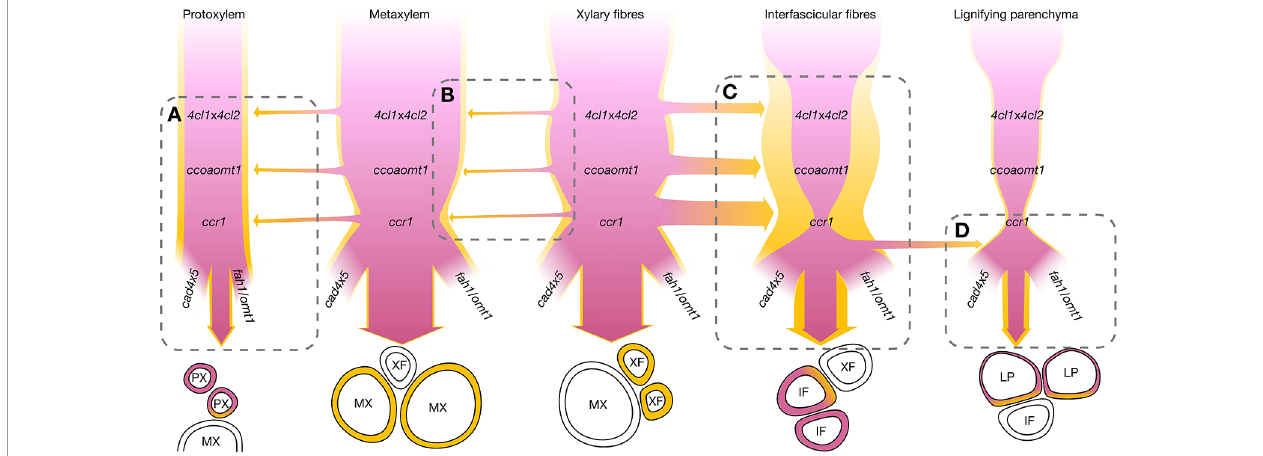
FIGURE 9 | Schematic representation of the regulation of coniferaldehyde accumulation in lignin for different cell types focusing on the genetic controls of the metabolism and cooperative supply. The sequence of the mutants in the metabolic pathways leading to coniferaldehyde are shown for each cell type. The cell autonomous control of coniferaldehyde accumulation is indicated by the width of the pink ribbon modi fi ed accordingly to the effect of the different mutations. The cell cooperative control of coniferaldehyde accumulation are indicated by the width of yellow ribbon with speci fi c neighboring cell types modi fi ed accordingly to the effect of the different mutations. Only interactions between neighboring cells are presented. (A) PX incorporate more coniferaldehyde when adjacent to MX independently of any particular mutations. (B) MX incorporates coniferaldehyde supplied by adjacent XF. The magnitude of cooperativity is largely independent of mutations, but both cell types are slightly reduced in coniferaldehyde in ccr1. Deciphering the relative impact of XF on MX is complicated by their constant close adjacency. (C) IF coniferaldehyde accumulation is highly affected by the 4cl x 4cl2, ccoaomt1 , and ccr1 mutations which can be bypassed by cooperation with XF. (D) LP behave similarly to IF without the cooperation of XF but show increased coniferaldehyde accumulation only in cad s, fah1 , and omt1 mutant plants possibly forming a metabolic sink for over-accumulating